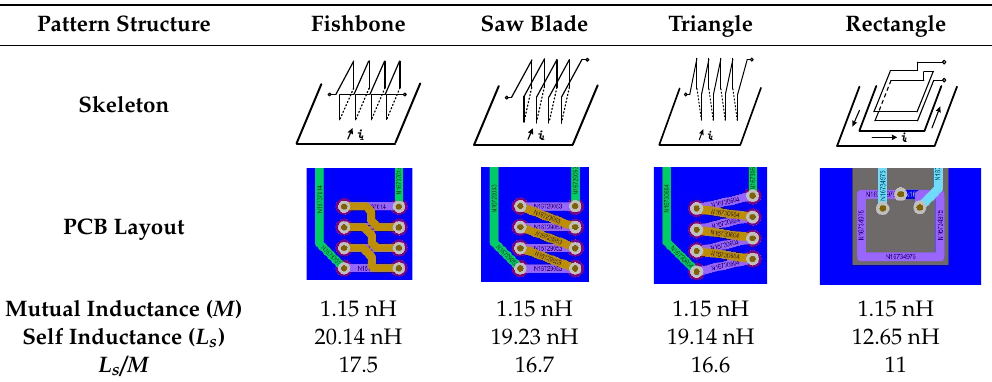
Table 1. Comparison of the dependent coil structure. Pattern Fishbone Saw Blade